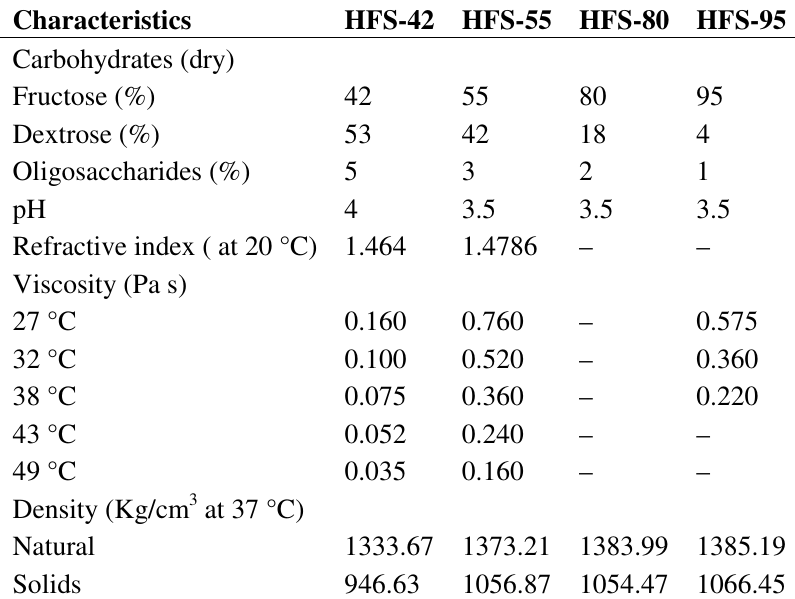
Table 1. Properties of high-fructose-syrup [9] *.